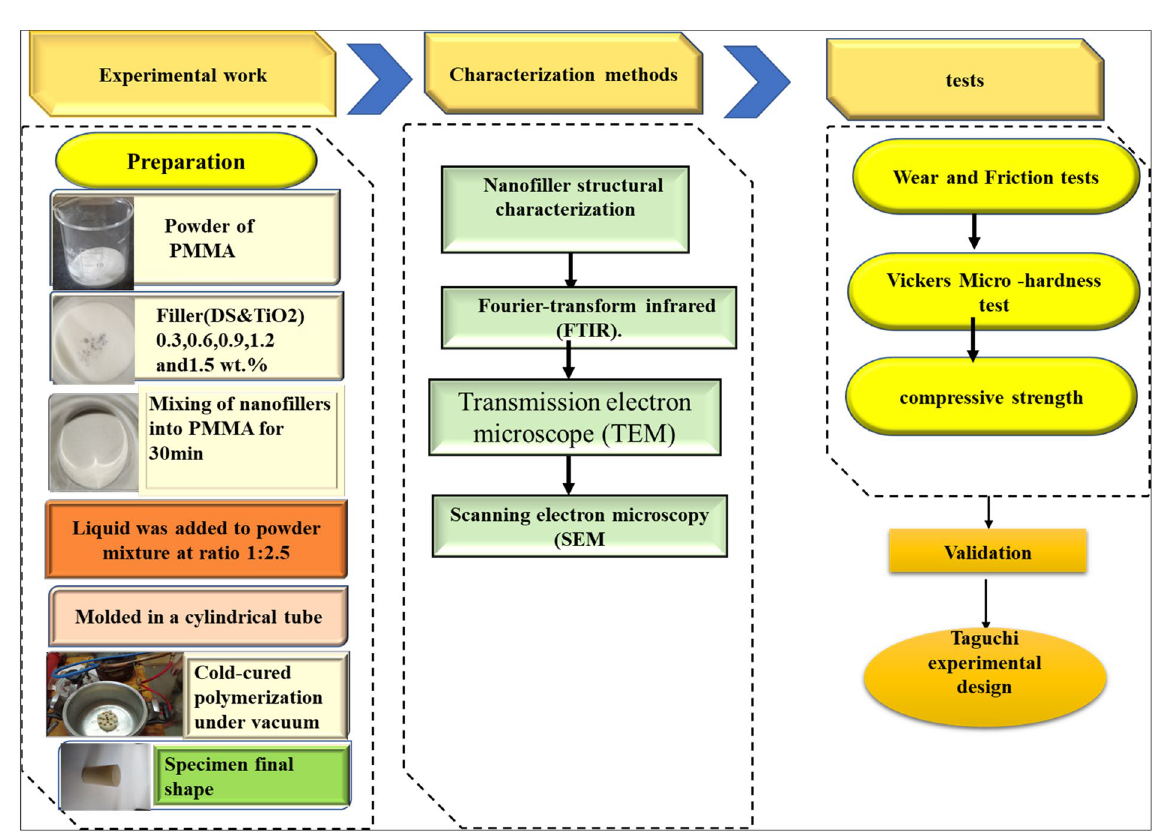
Figure 1. An overview schematic of the methodology present in the